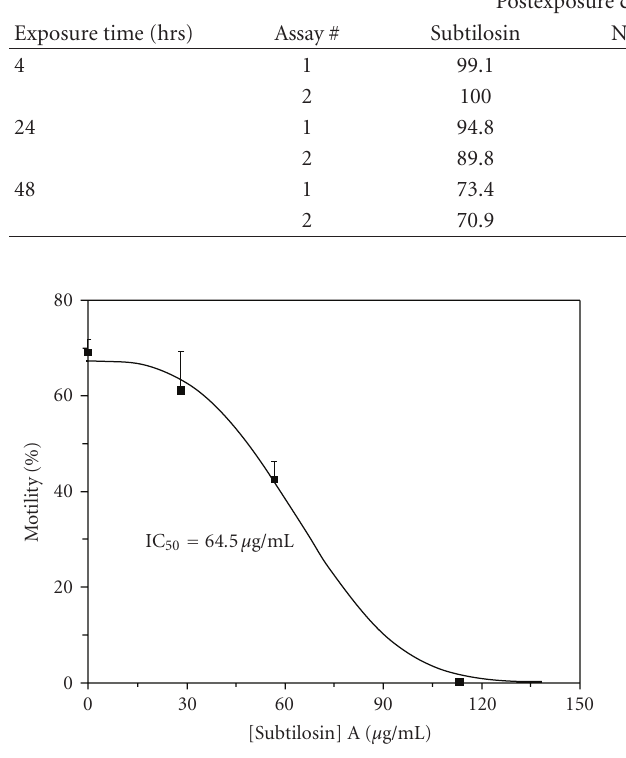
Figure 1: Subtilosin A immobilizes human spermatozoa in a dose-dependent manner. The percentage of motile spermatozoa in pooled whole semen was determined 30 seconds after mixing with subtilosin A, at di ff erent final concentrations, as indicated. All data were adjusted to a normal control motility of 70% and subjected to arcsine transformation before further analysis. Values are expressed as average % motility. Error bars are 90% confidence